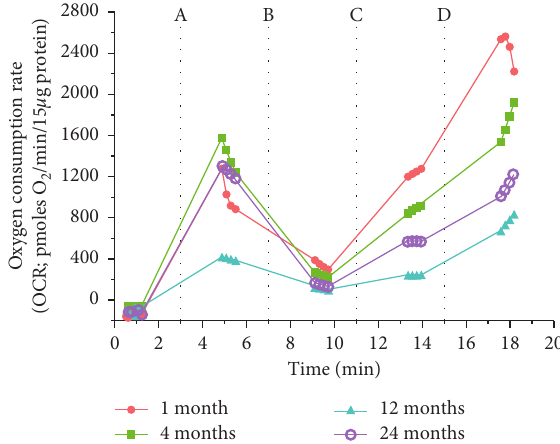
Figure 5: Typical traces of brain (frontal cortex) mitochondrial bioenergetics using Seahorse Extracellular Flux Analyzer from rats that are 1 month, 4 months, 12 months, and 24 months of age. Each line shown is representative point-to-point display of patterns of OCR respiration rates at 1, 4, 12, or 24 months of age. Oxygen consumption rates (OCR) were measured with addition of sub- strates/inhibitors of electron transport chain. Vertical lines rep- resent addition of compounds used to determine the various respiration states: (A) substrates (pyruvate, malate, and adenosine diphosphate) for State III; (B) oligomycin for State IV; (C) carbonyl cyanide 4-(trifluoromethoxy)phenylhydrazone (FCCP) for State V 1 ; and (D) succinate and rotenone for State V 2